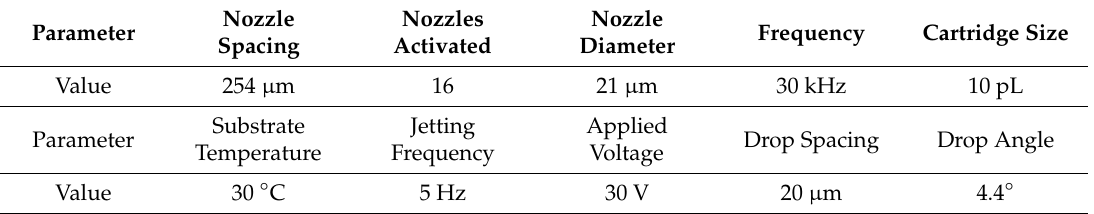
Table A1. Summary of the settings used in the material printer for silver electrode